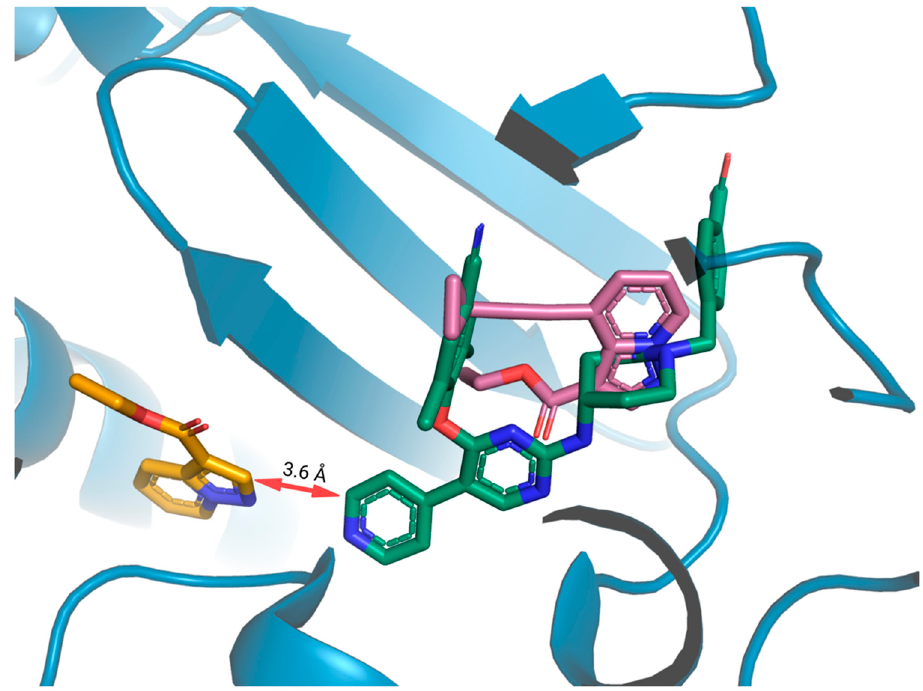
Figure 7. Superposition of WT RT (blue), compound 27 (magenta) and K07-15 compound (green) in the NNIBP. Compound B-1 (orange) is shown in the NNRTI Adjacent site (PDB 4KFB). Created with PyMOL and BioRender.com. Nitrogen atoms are blue and oxygen atoms are red.